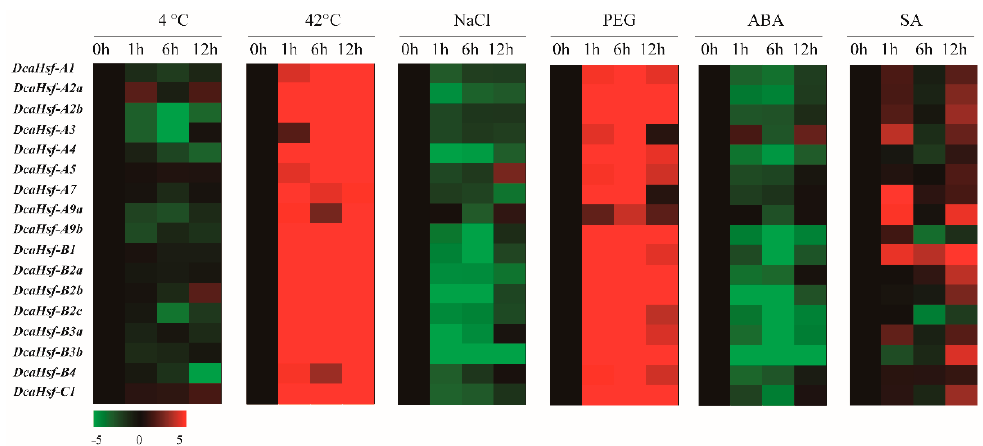
Figure 6. Expression levels of DcaHsfs under various abiotic stresses, determined by qRT-PCR. The di ff erent colors correspond to log 2 -transformed fold change, green indicates down-regulation, and red represents up-regulation.